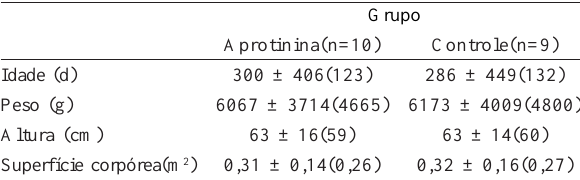
Tabela 1. Idade (d), peso (g), altura (cm) e superfície corpórea (m 2 ) (média ± desvio padrão), dos grupos Aprotinina e Controle. A mediana aparece entre parênteses.